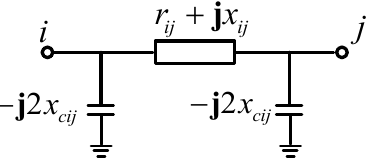
Figure 5. Single-phase equivalent circuit diagram of the lumped π -model of a cable between two